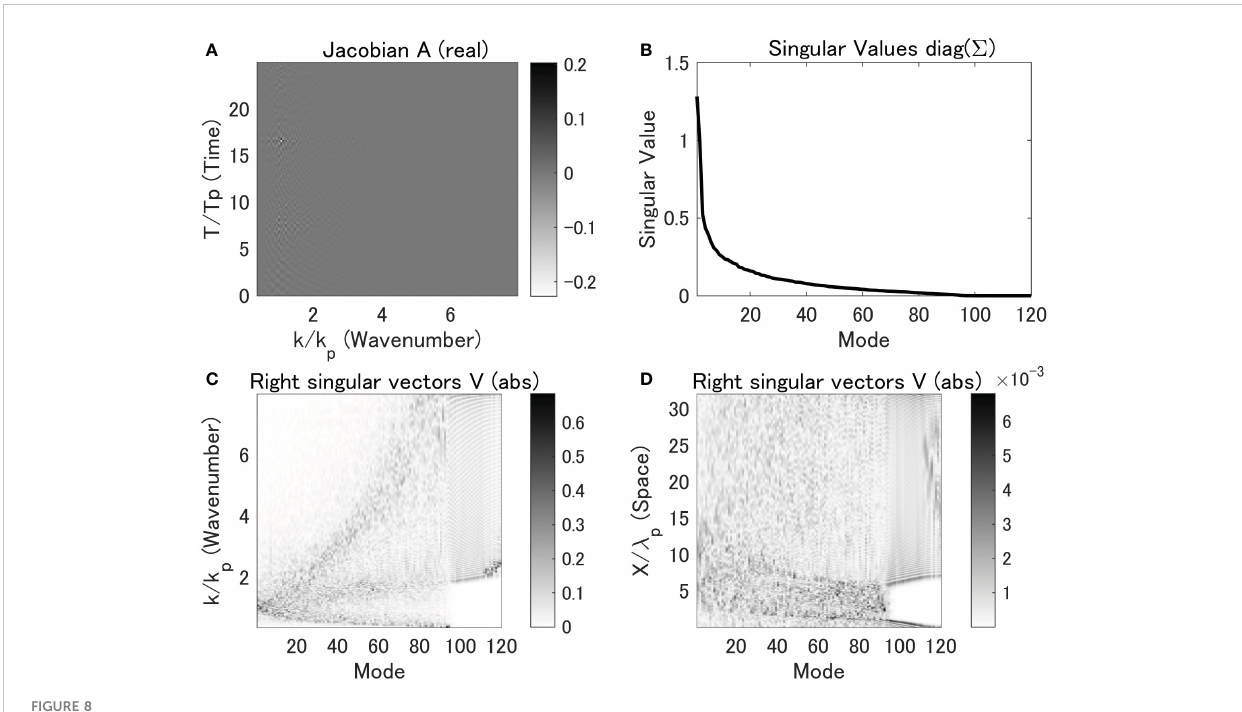
FIGURE 8 Approximated Jacobian obtained from the linear dispersion relation. (A) The real part of the approximated Jacobian A ’ , (B) the singular values of the approximated Jacobian, (C) the absolute values of the right singular vectors of the approximated Jacobian in the wavenumber domain, and (D) the absolute values of the right singular vectors transformed to the spatial